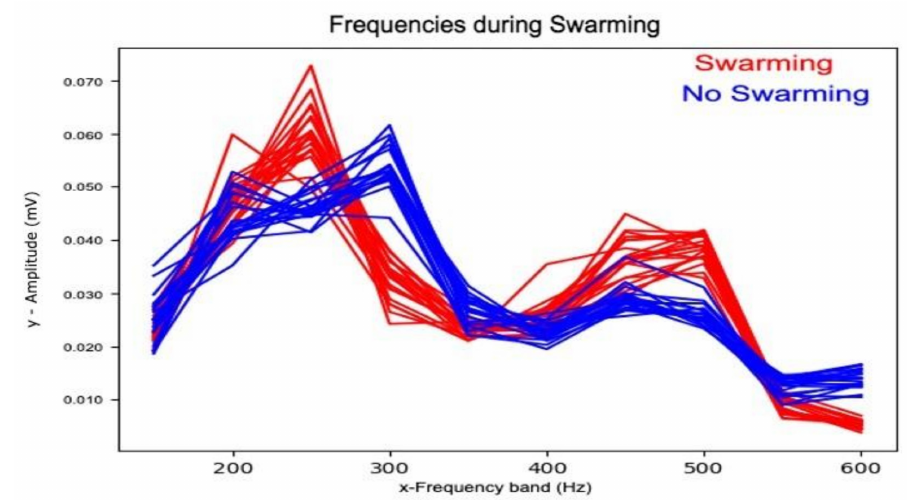
Figure 4. Frequencies 5 days before a swarming event in the frequency band of 150–600